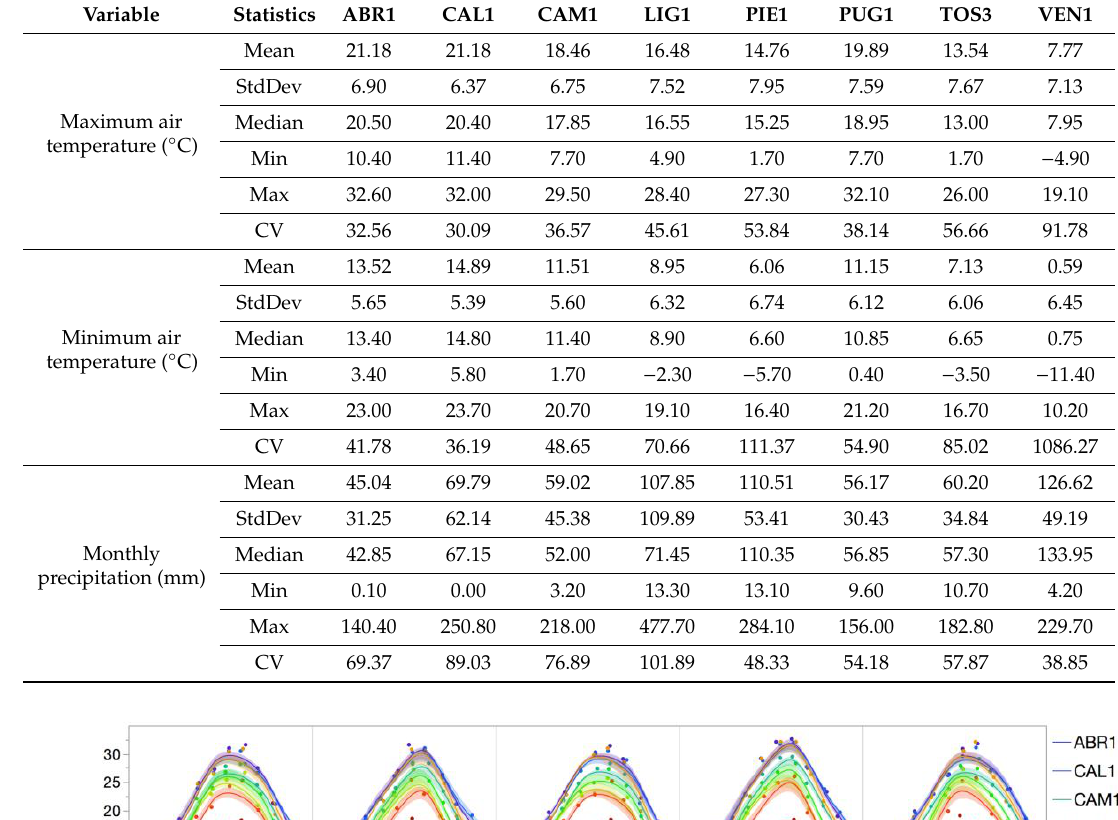
Table 3. Summary statistics of the monthly climatic variables (2009–2013).